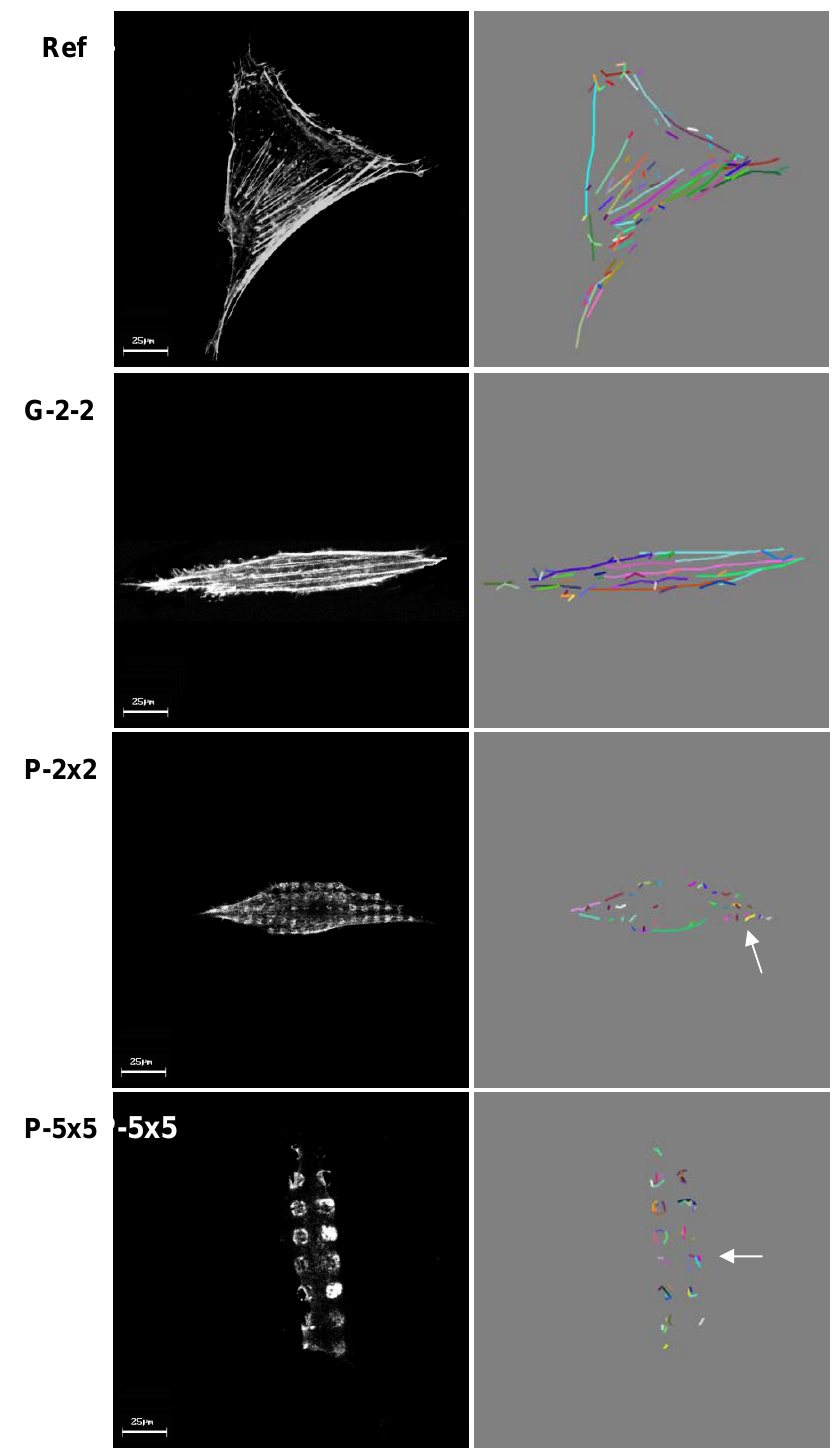
Figure 8. Quantification of actin filaments. left column: confocal images (LSM 410, Carl Zeiss), right column: automatically processed images obtained from FilaQuant software. Actin filaments are shown as colored lines. Note that the actin filament length is dramatically reduced (arrows) on the pillared surfaces P-2×2 and P-5×5, but cell orientation is comparable to